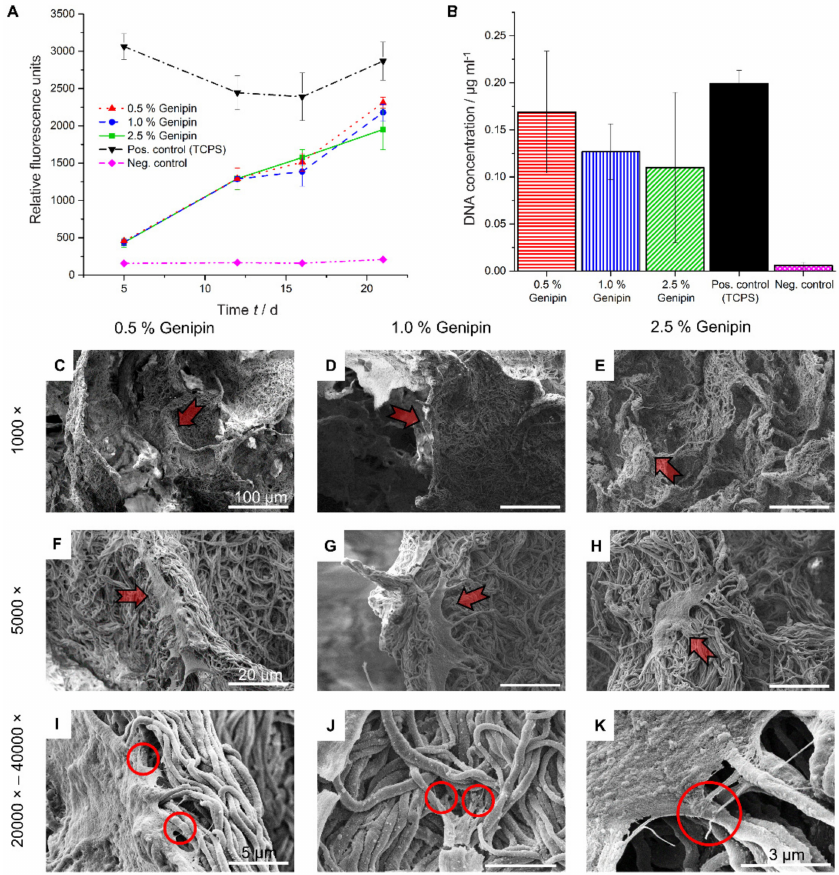
Figure 3. Cell viability and cell morphology on scaffolds. ( A ) Metabolic activity measurements of HDF at various time points using the PrestoBlue assay. ( B ) DNA quantification at day 23 using the PicoGreen assay. ( C – K ) SEM images off the cell morphology at the end of the incubation time (day 23), arrows indicate adhering HDF. ( C , F , I ) Scaffolds cross-linked with 0.5% genipin. ( D , G , J ) Scaffolds cross-linked with 1.0% genipin. ( E , H , K ) Scaffolds cross-linked with 2.5% genipin. ( C – E ) Scale bar = 100 µ m, ( F – H ) scale bar = 20 µ m, ( I , J ) scale bar = 5 µ m, ( K ) scale bar = 3 µ